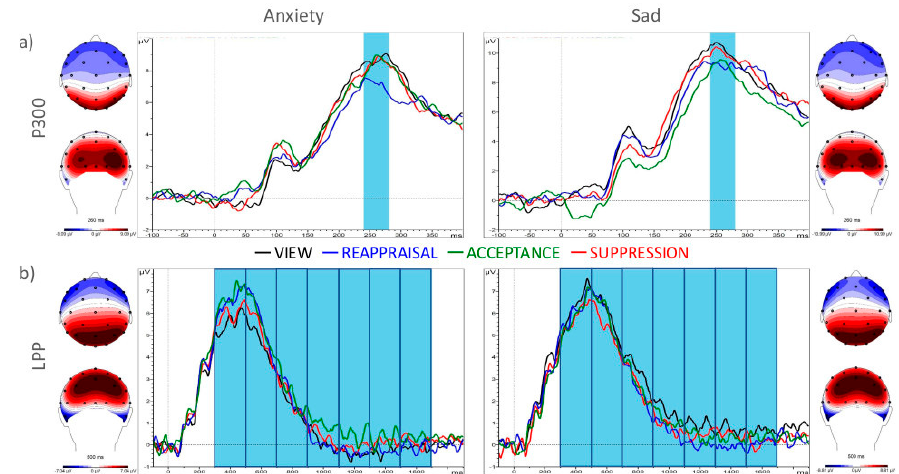
Figure 4. Electroencephalographic results. ( a ) the P300 mean averaged electrocortical signals for anxiety-inducing (left) and sadness-inducing pictures (right); ( b ) the LPP mean averaged electrocortical signals for anxiety-inducing (left) and sadness-inducing pictures (right). Upper column: Di ff erential electrocortical signal (averaged for O1 and O2) of ER strategies for anxiety- (left) and sadness-inducing (right) pictures; lower column: Di ff erential electrocortical signal (averaged for P3, P4, Pz, CP1, and CP2) of ER strategies for anxiety- (left) and sadness-inducing (right) pictures; blue bars depicted extracted time windows.